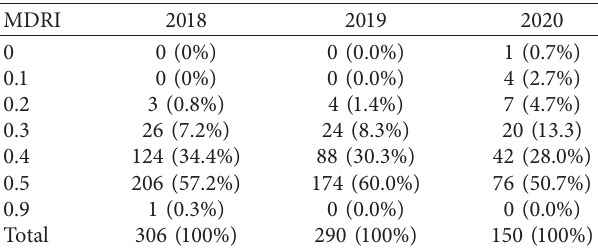
Table 4: Distribution of multiple-drug resistance indexes of bacterial isolates from 2018, 2019, and 2020 at Bolgatanga Regional Hospital.